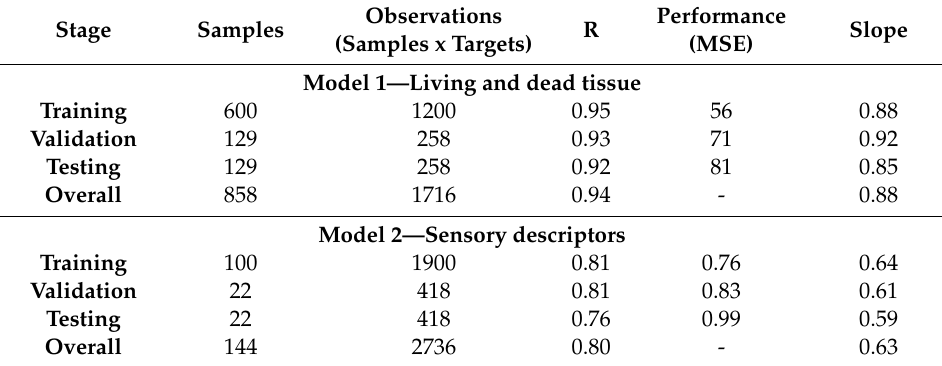
Table 2. Statistical results from the two artificial neural network